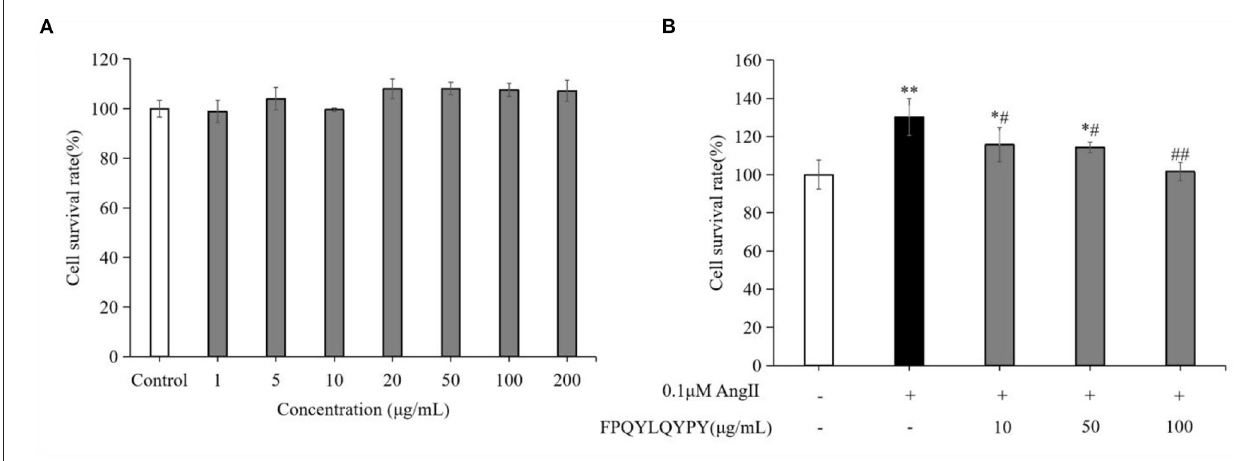
FIGURE 4 | FPQYLQYPY inhibited proliferation of Ang II-stimulated VSMCs. (A) Cytotoxicity of FPQYLQYPY in VSMCs cells measured by CCK-8. (B) FPQYLQYPY inhibited Ang II-stimulated proliferation of VSMCs. Data are expressed as mean ± SD. * P < 0.05 and ** P < 0.01, respectively, as compared to the control group. # P < 0.05 and ## P < 0.01, respectively, as compared to the Ang II-treated